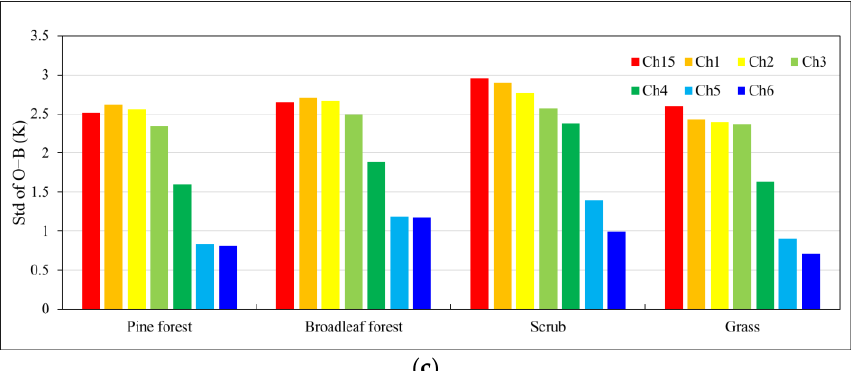
Figure 12. Histograms of ( a ) data volume, ( b ) the average O − B of observations, and ( c ) standard deviation of observations for AMSU-A channels 1 – 6 and 15 on four vegetation types in East Asian land areas from June to August 2019.